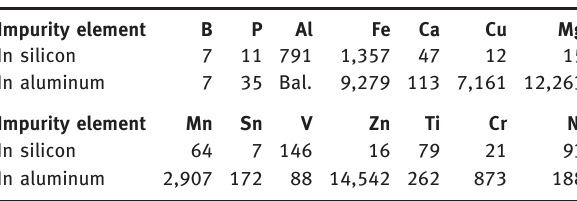
Table 1: Impurity content in the raw materials (ppmw). Impurity element